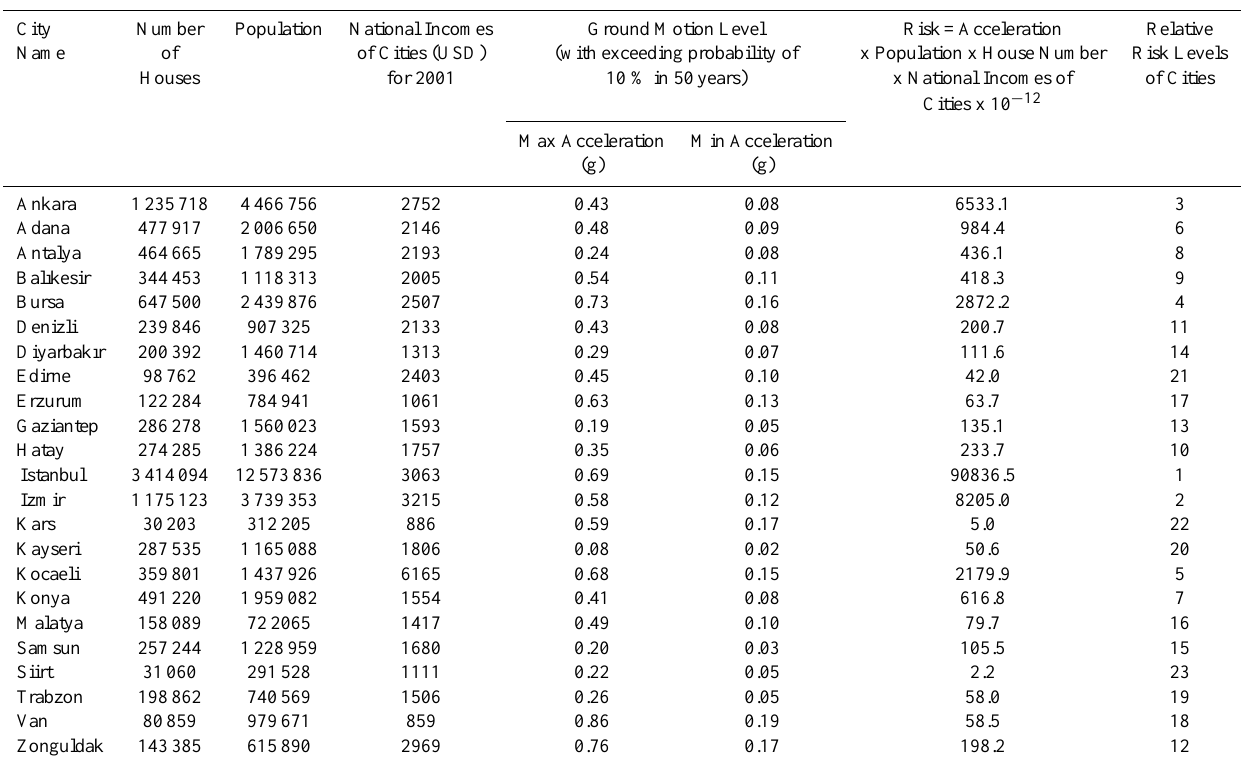
Table 5. Cities and their relative risk levels.